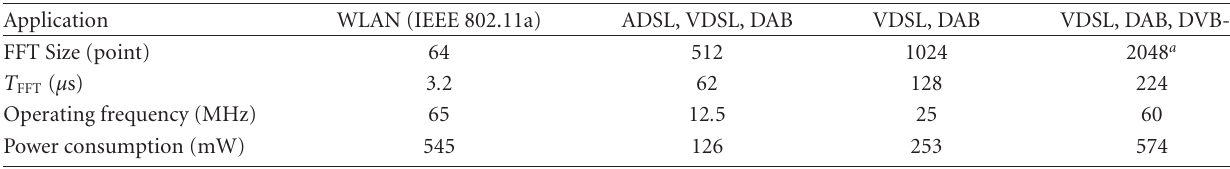
Table 4: FFT size, T FFT , frequency, power consumption, and power e ffi ciency.